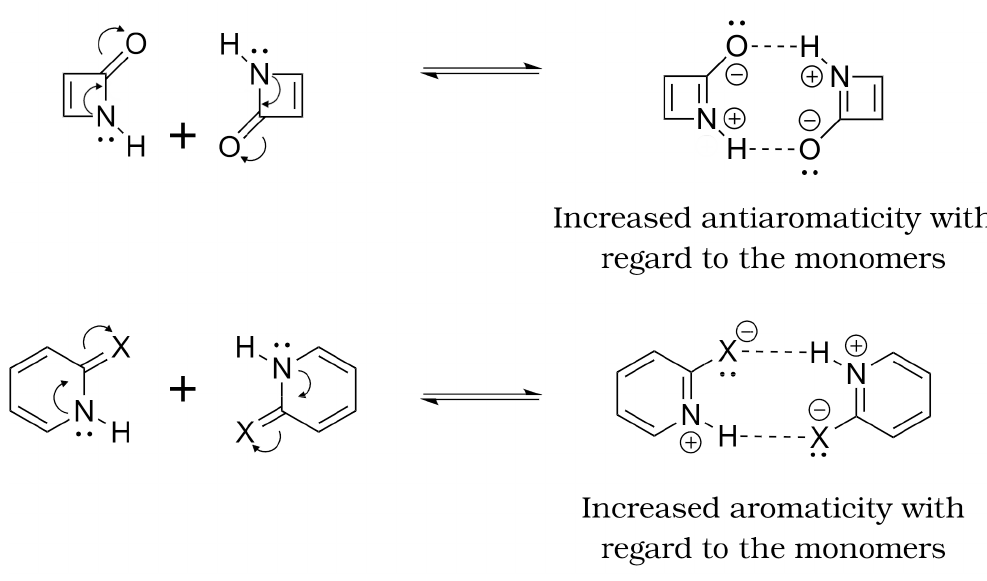
Figure 7. Alternative interpretation of the AMHB in the DCR dimers compared to that offered in Figure 6 as increases in aromaticity and antiaromaticity in the (i) 2HP and 2AP on one hand and (ii) the AZA and AZH on the other,